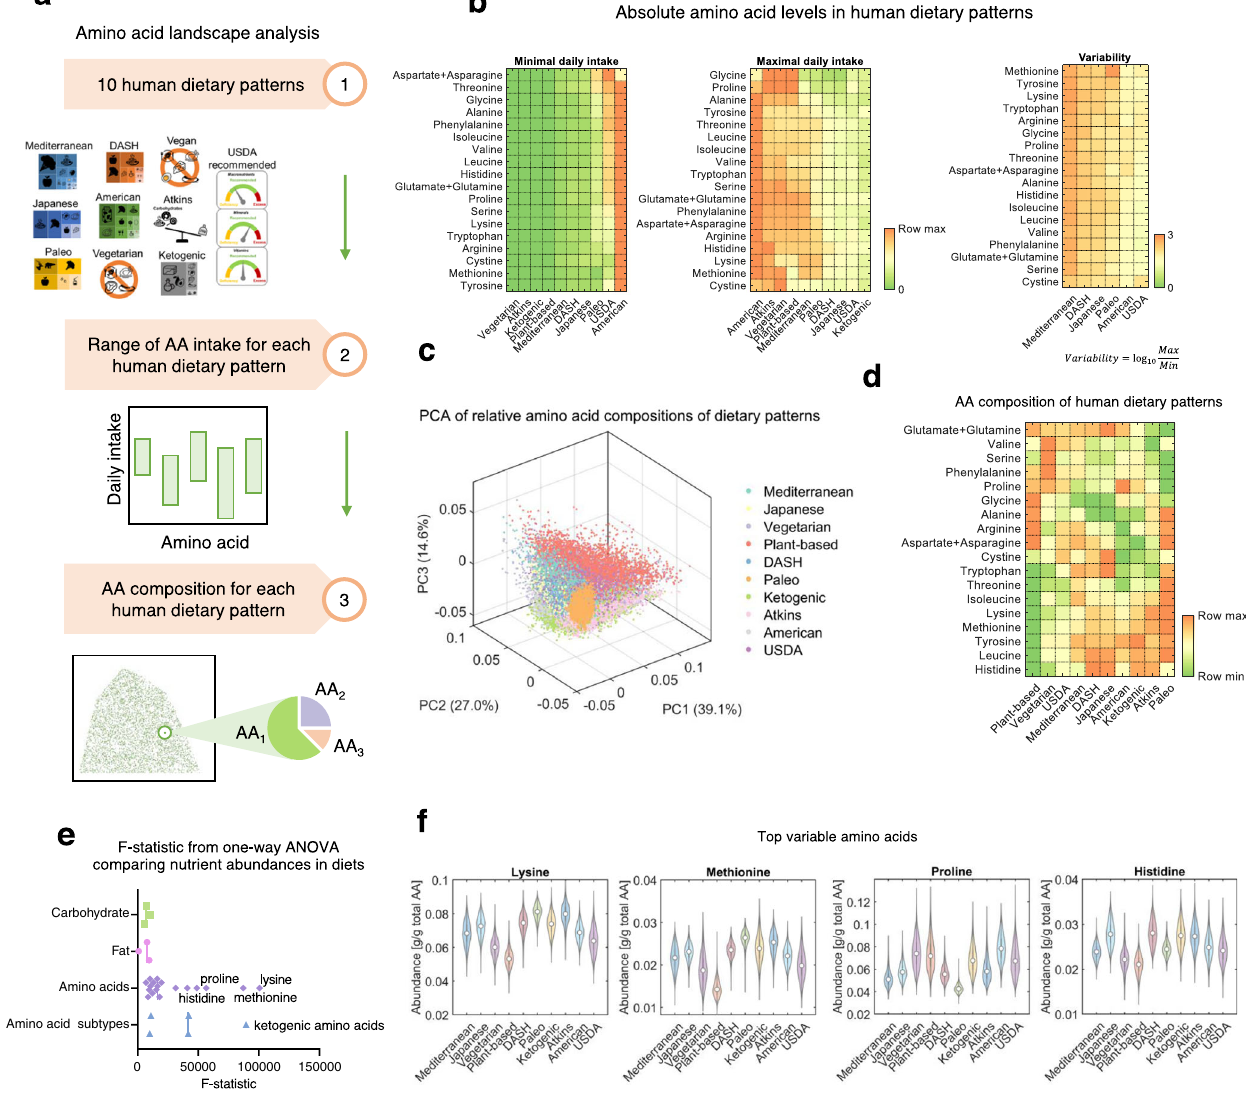
Fig. 2 | Amino acid landscape ofhuman diets. a Work fl ow for the computational modeling of amino acid abundance in human dietary patterns. Food images used withpermissionfromMicrosoft. b Absolute levelsof aminoacidsinhumandietary patterns quanti fi ed by the minimal and maximal daily intake values of amino acids in each dietary pattern. c Principal components analysis (PCA) of relative amino acid compositions of human diets sampled for all ten dietary patterns. Each dot